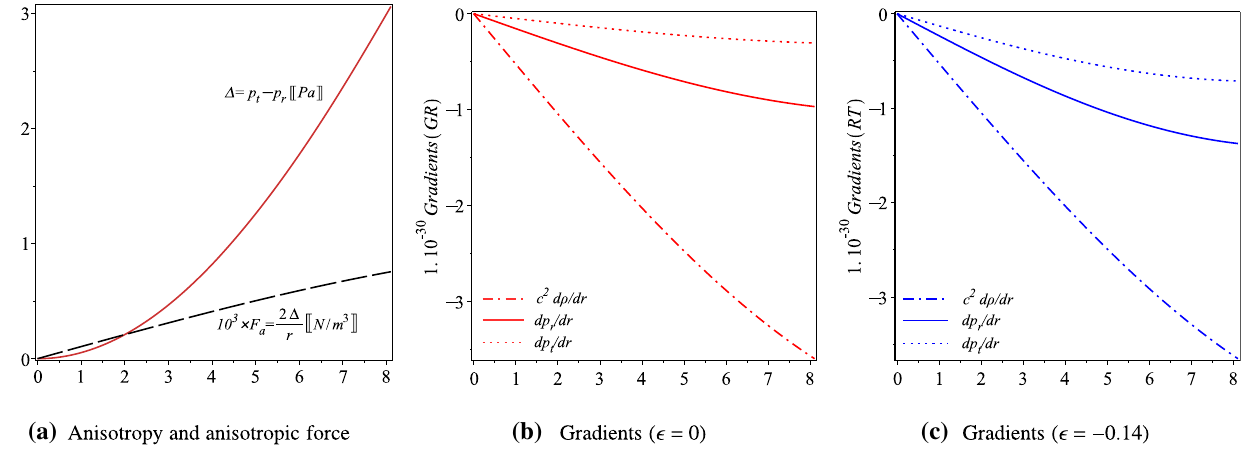
of spherical symmetry as discussed after (16). For (cid:2) = 0 and (cid:2) (cid:6)= 0, the gradients of the density, tangential and radial pressures given by Eqs. (29)–(31) versus the radial coordinate r in km of the pulsar Her